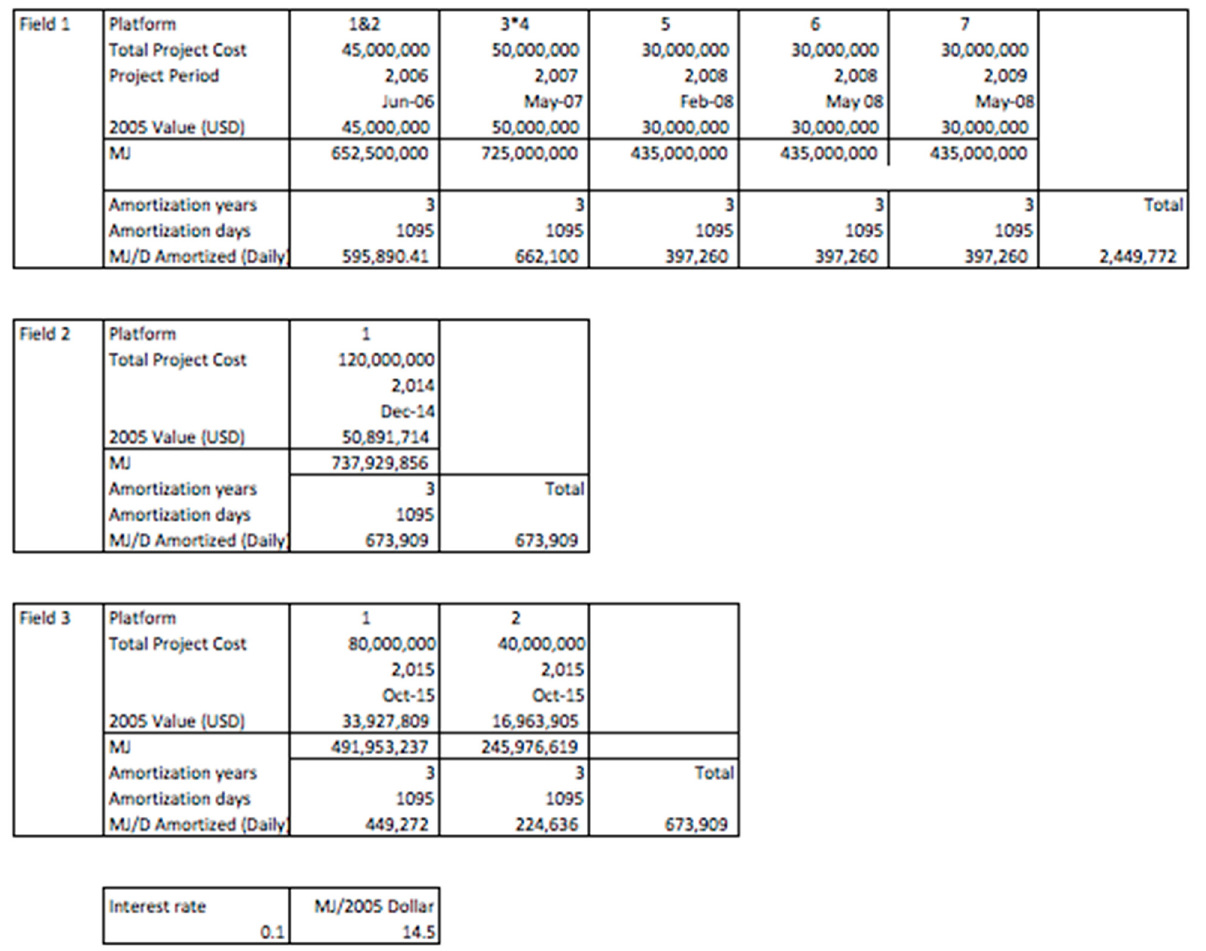
Figure A2. Construction Energy Calculation.